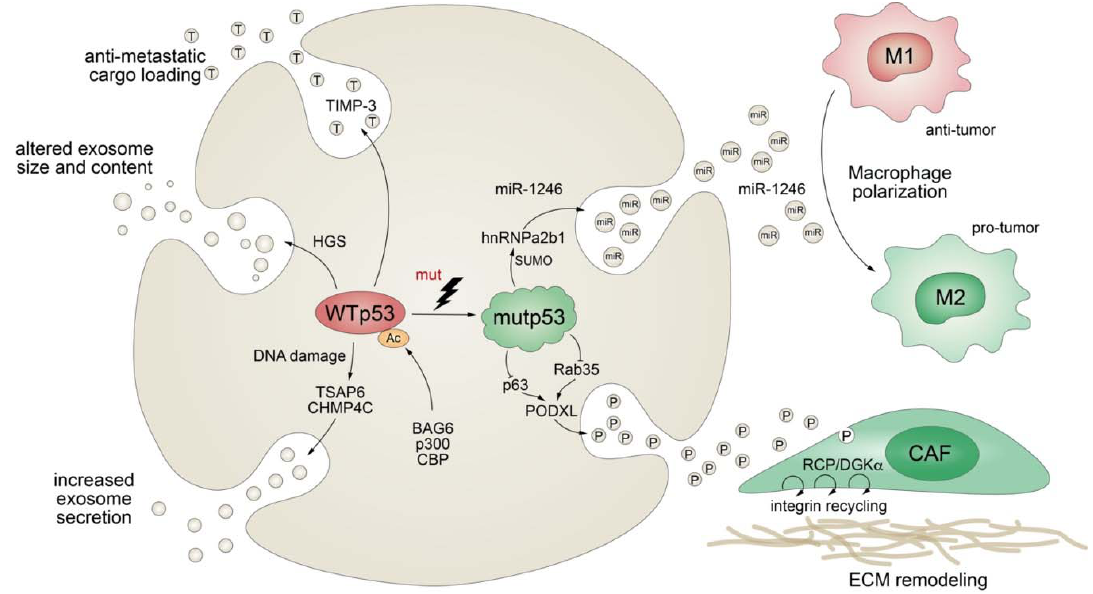
Figure 5. Mutant p53 shapes the tumor cell secretome at the exosome level. TP53 mutations abrogate wild ‐ type p53 ‐ mediated effects on exosome secretion, size, and cargo and actively control exosomal secretion of miR ‐ 1246 and podocalyxin (PODXL), thereby affecting macrophage M1 ‐ M2 polarization and extracellular matrix (ECM) remodeling by cancer ‐ associated fibroblasts